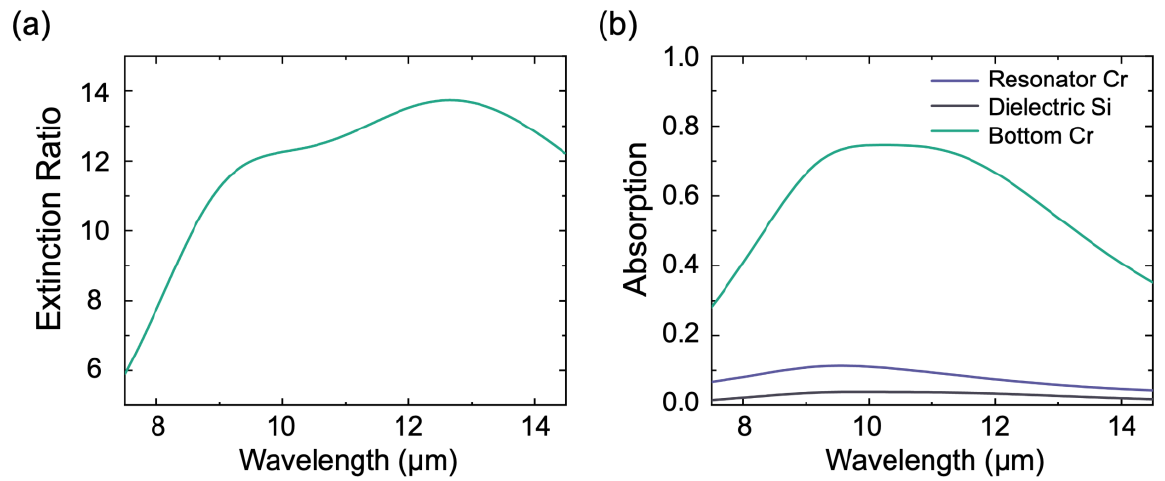
Figure 3. ( a ) Polarization extinction ratio of designed MIM absorber; ( b ) absorbed energy distribution within each component of absorber structures.